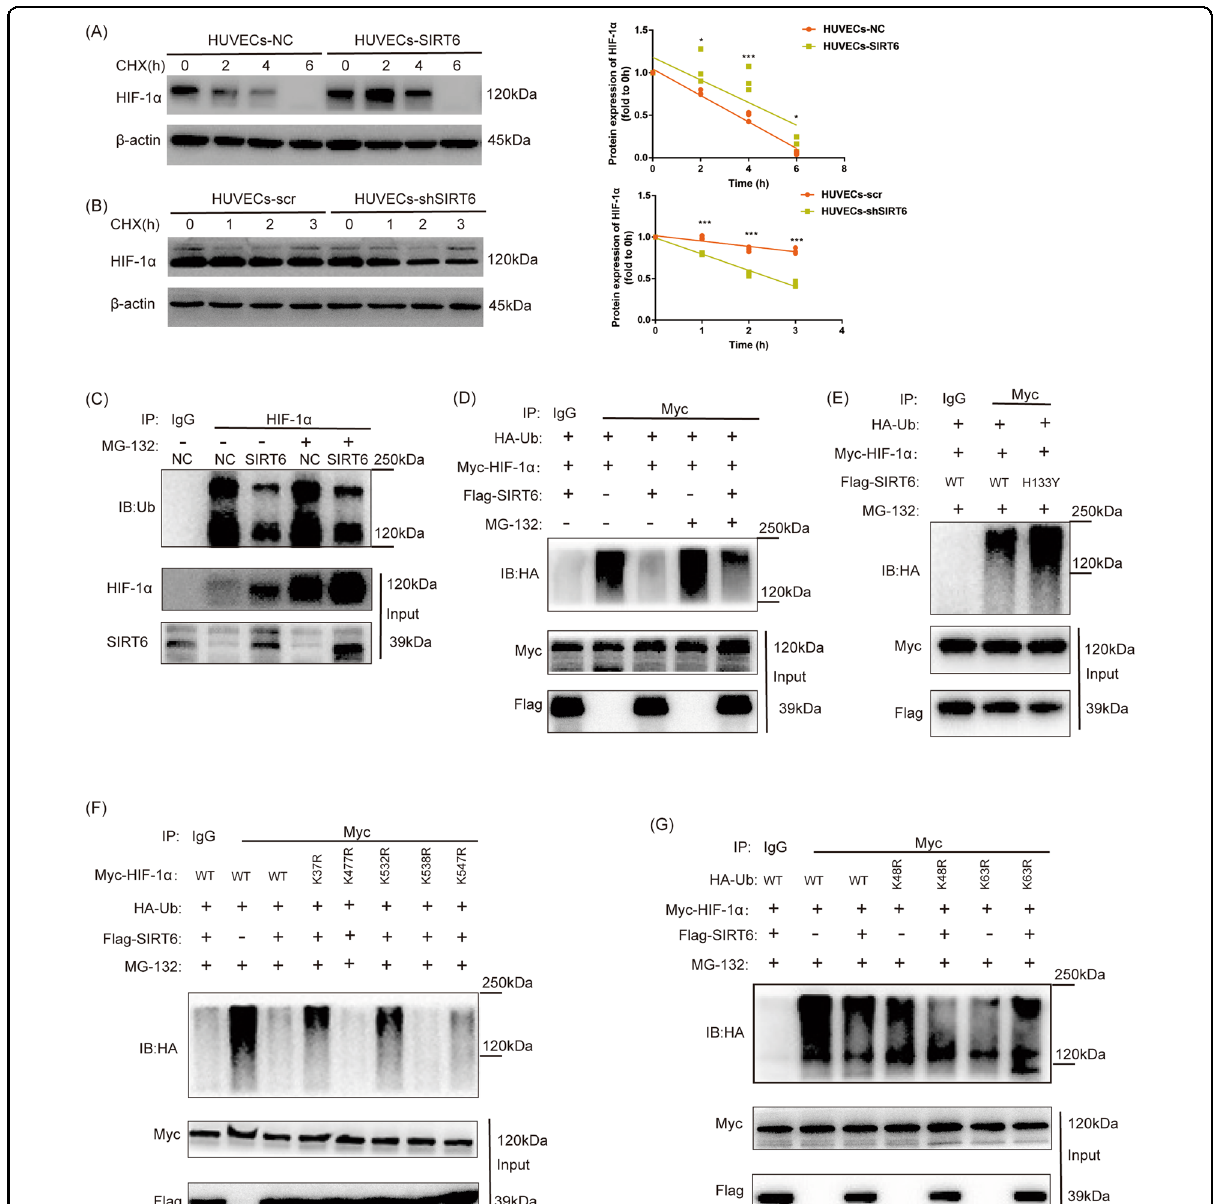
Fig. 4 Overexpression of SIRT6 inhibited ubiquitin-proteasome degradation of HIF-1 α . ( C , D , E , F , G : Detection of ubiquitination of HIF-1 α performed by Co-IP under hypoxia). A Overexpression of SIRT6 prevented the degradation of HIF-1 α under hypoxia after the treatment of CHX (20 µg/ml for 0 – 6 h). B Downregulation of SIRT6 promoted the degradation of HIF-1 α under hypoxia after the treatment of CHX (20 µg/ml for 0 – 3 h). C Ubiquitination of HIF-1 α in HUVECs-NC and HUVECs-SIRT6 with or without proteasome inhibitor MG-132 treatment (10 μ m, 6 h). D SIRT6 promoted deubiquitination of HIF-1 α . HUVECs were transfected with HA-Ub, Myc-HIF-1 α , and SIRT6-Flag, respectively. E Inhibition of histone deacetylase activity of SIRT6 inhibited its deubiquitination effect at HIF-1 α . HUVECs were transfected with HA-Ub, Myc-HIF-1 α , and SIRT6-Flag (wild type: WT or histone deacetylase activity inhibited mutant: H133Y), respectively. F K37 and K532 are the main SIRT6 deubiquitination sites of HIF-1 α . HUVECs was transfected with HA-Ub, SIRT6-Flag, and different Myc-HIF-1 α mutant (K37R/K477R/K532R/K538R/K547R). G SIRT6 promoted the deubiquitination of HIF-1 α via Ubiquitin-K63. HUVECs were transfected with SIRT6-Flag, Myc-HIF-1 α , and HA-Ub (WT, K48R, and K63R mutant) (* P < 0.05, *** P <